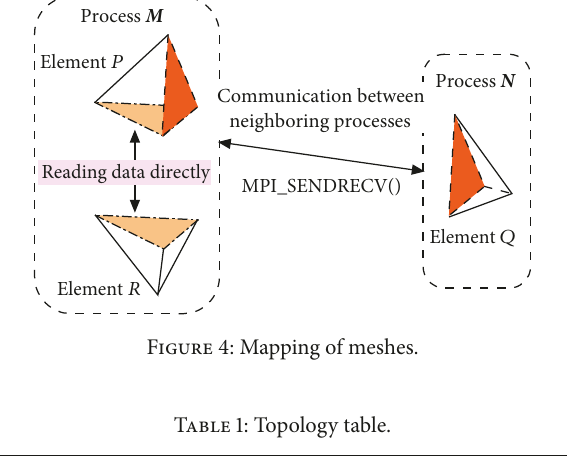
Figure 1: Flow chart.